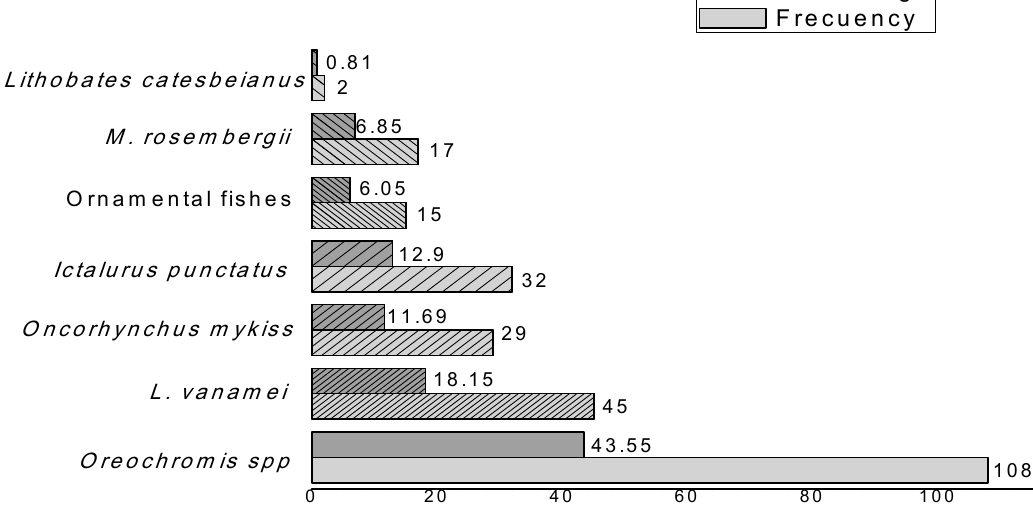
Figure 5. Aquaculture producers surveyed in Mexico. Species cultivated (2019).